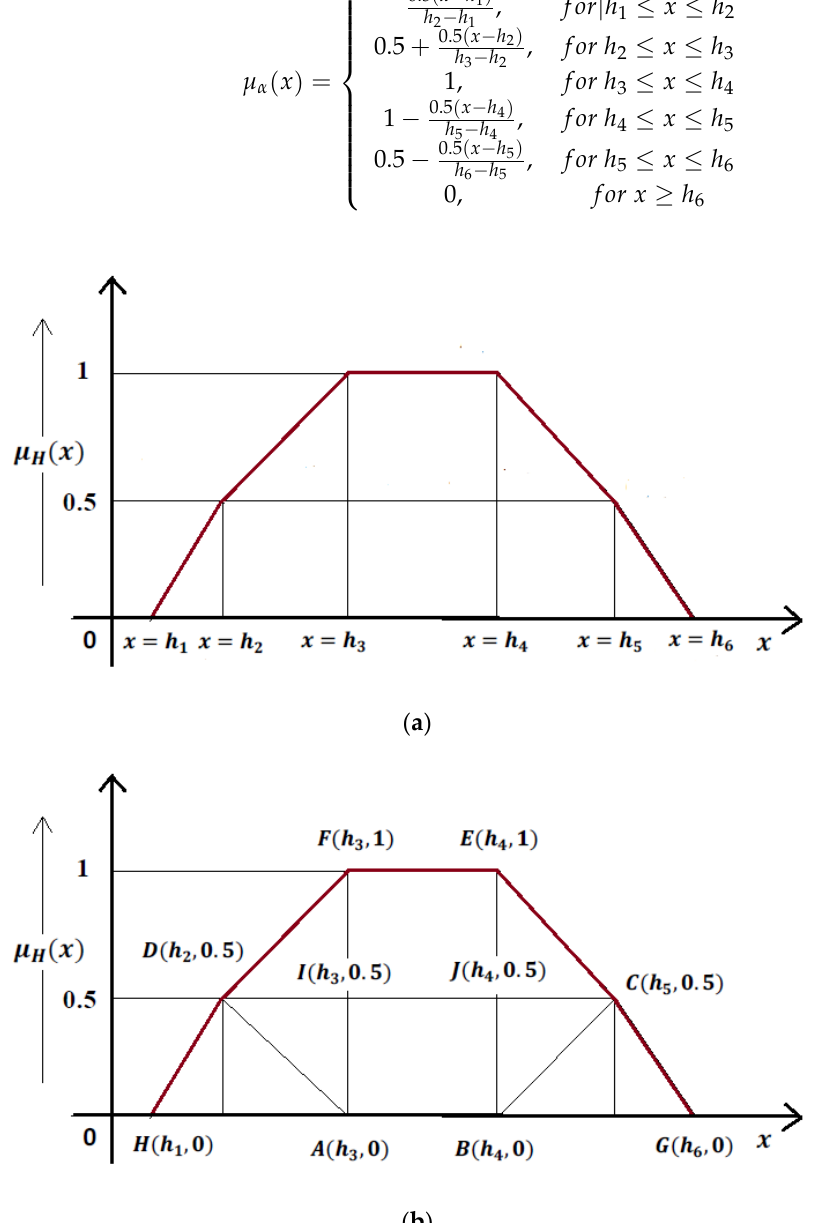
Figure 2. ( a ) Representation of the membership function of linear hexagonal fuzzy number (HFN). ( b ) Hexagonal fuzzy number as union of different regions.